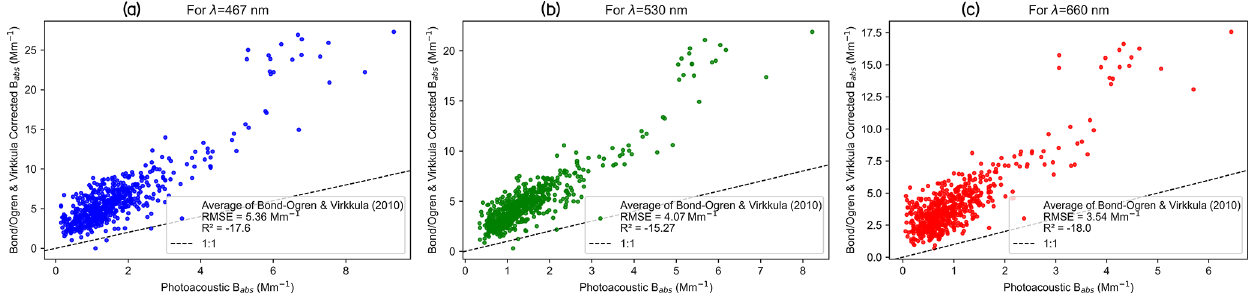
Figure 5. Comparison between PSAP absorption coefficients, corrected for using the average of the Bond–Ogren and unrevised Virkkula (2010) algorithms, and the reference PASS absorption coefficients measured at the SGP site corresponding to the (a) 467nm, (b) 530nm, and (c) 660nm wavelengths.